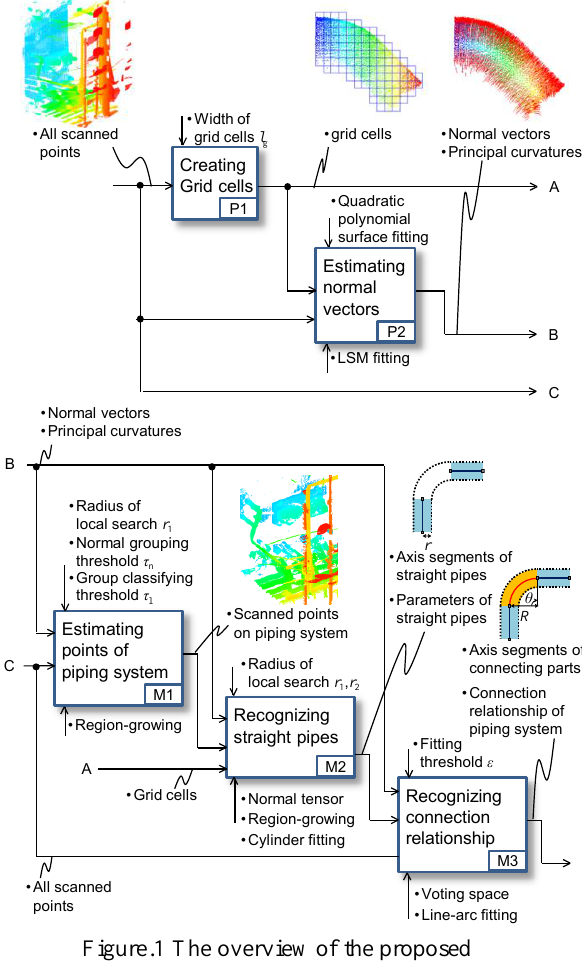
Figure.1 The overview of the proposed piping system recognition